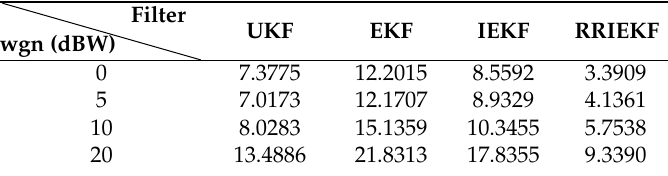
Table 4. RMS estimation errors for the non-linear system model.